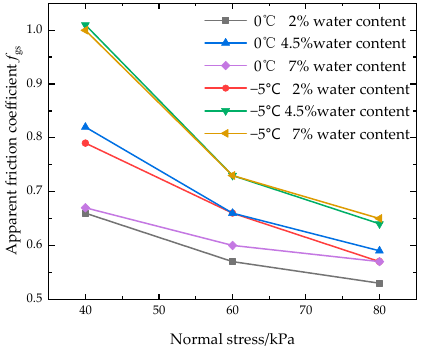
Figure 14. Change curve of apparent friction coefficient.